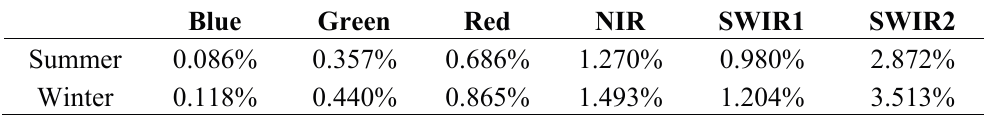
Table 4. Atmospheric uncertainty for different day cross calibration over Libya